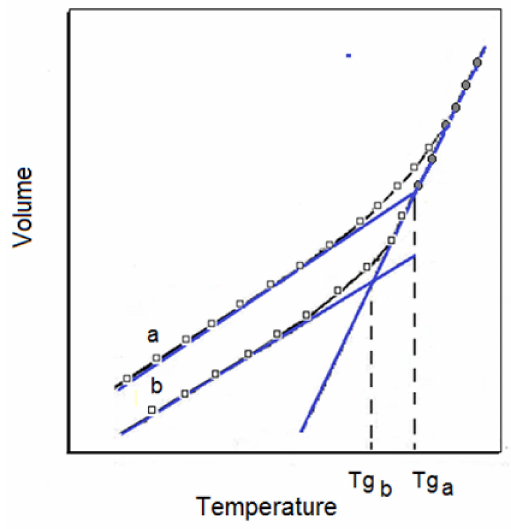
Figure 1. The temperature dependence of the volume of an amorphous polymer at a constant pressure. The curve a corresponds to a short time and b to a longer time after solidification